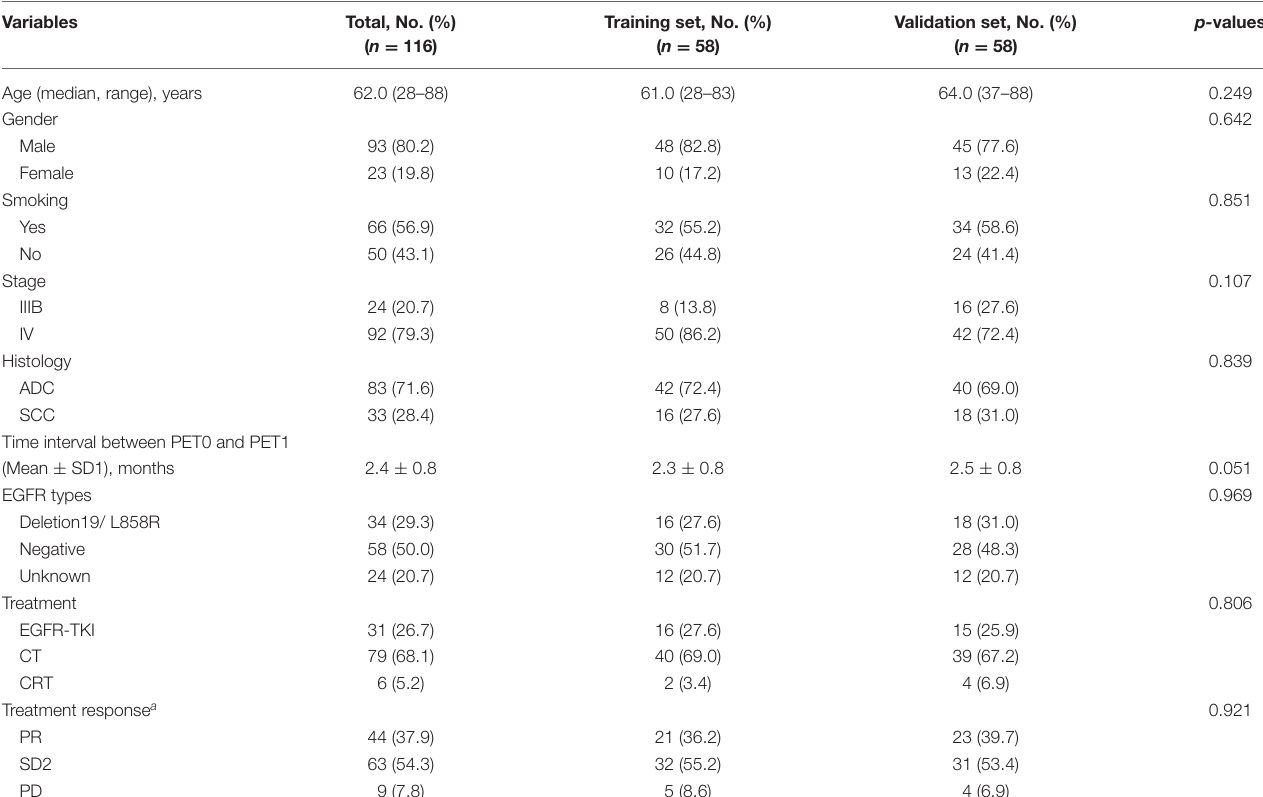
TABLE 1 | Patient